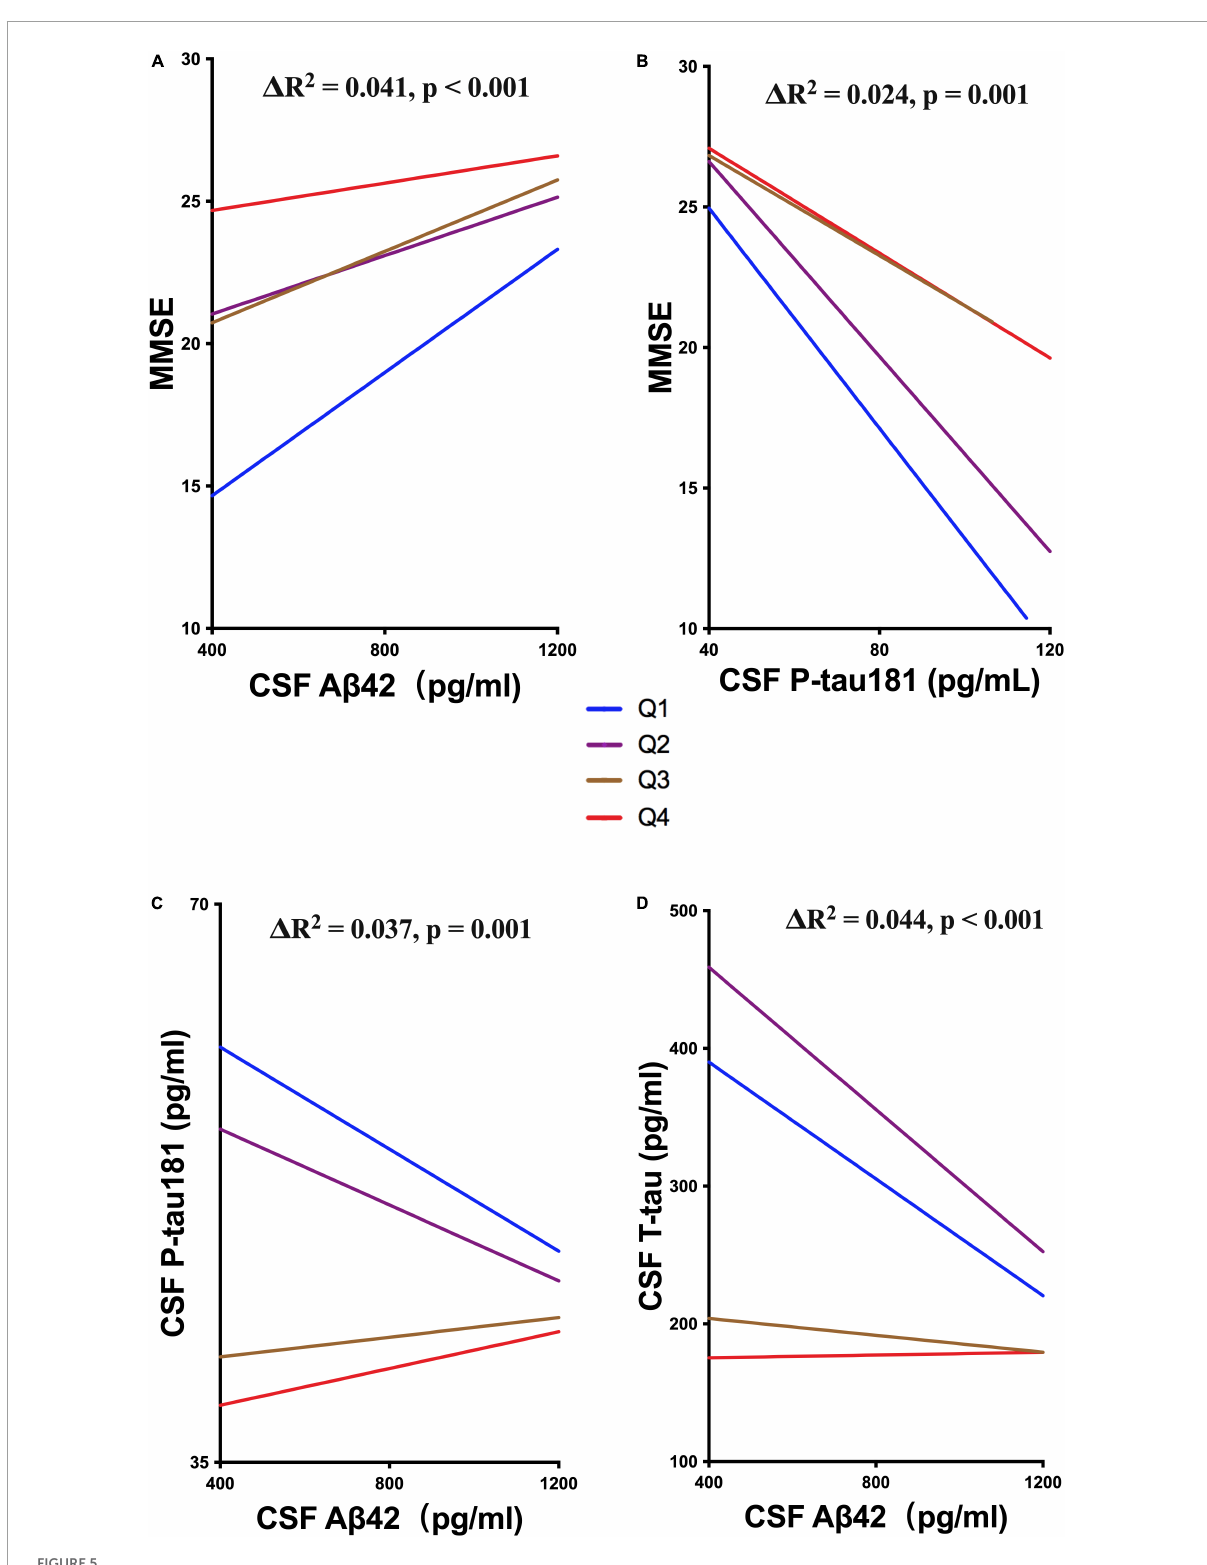
FIGURE5 Moderating effect of UA and ATN biomarkers. (A,B) Hierarchical regression analysis of the moderating effect of the sUA levels in the association of CSF A β 42 and P-tau181 with MMSE scores. (C,D) Hierarchical regression analysis of the moderating effect of the sUA levels in the association of CSF A β 42 with P-tau181 and